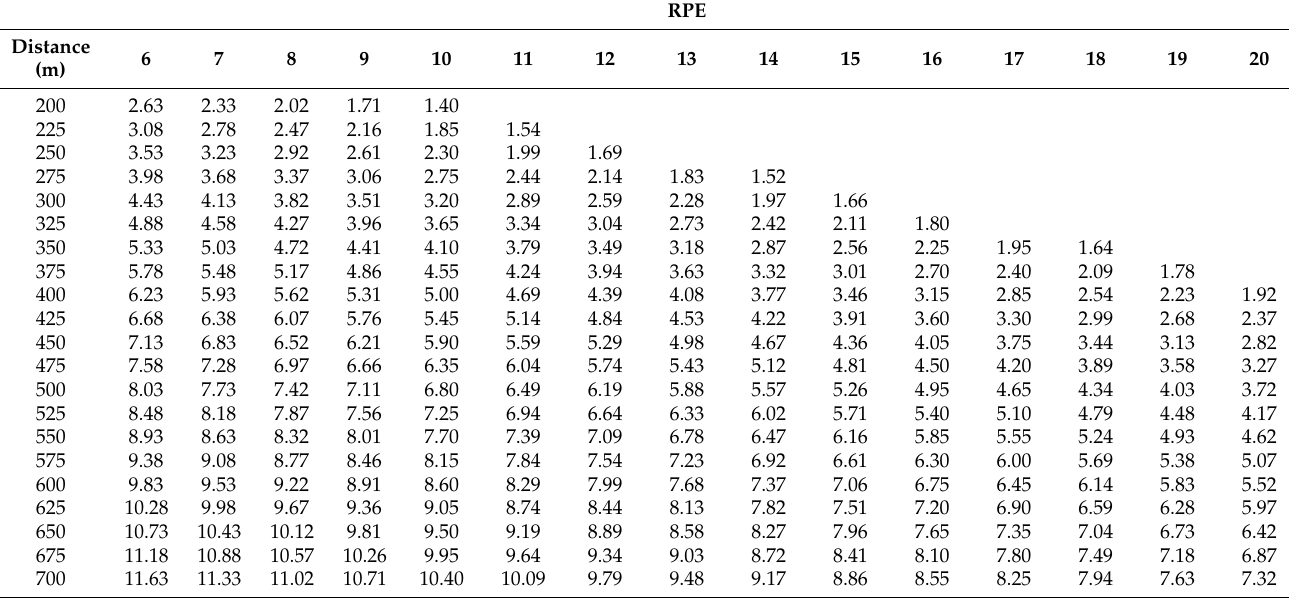
Figure 2. Bivariate relationship between the 6-min walk test (6MWT) + terminal rating of perceived exertion (RPE) prediction equations and observed values for maximal Metabolic Equivalents (Max METs, a ), Metabolic Equivalents at the ventilatory threshold (METs@VT, b ) and the standardized residuals for Max METs ( c ) and METs@VT ( d ). Tabular presentations of Max METs and METs@VT in relation to 6MWT distance and terminal RPE are presented in Tables 2 and 3. In terms of convenience of use, it is simple to compare 6MWT distance and terminal RPE to derive Max METs and METs@VT. Table 2. Estimate of maximal Metabolic Equivalents in relation to 6-min walk test (6MWT) distance (m) and terminal rating of perceived exertion (RPE). For convenience of presentation, 6MWT distance is incremented by 50 m. However, as the equation is linear, interpolation of intermediate values is appropriate.